Question: In one sentence, what is this figure communicating?
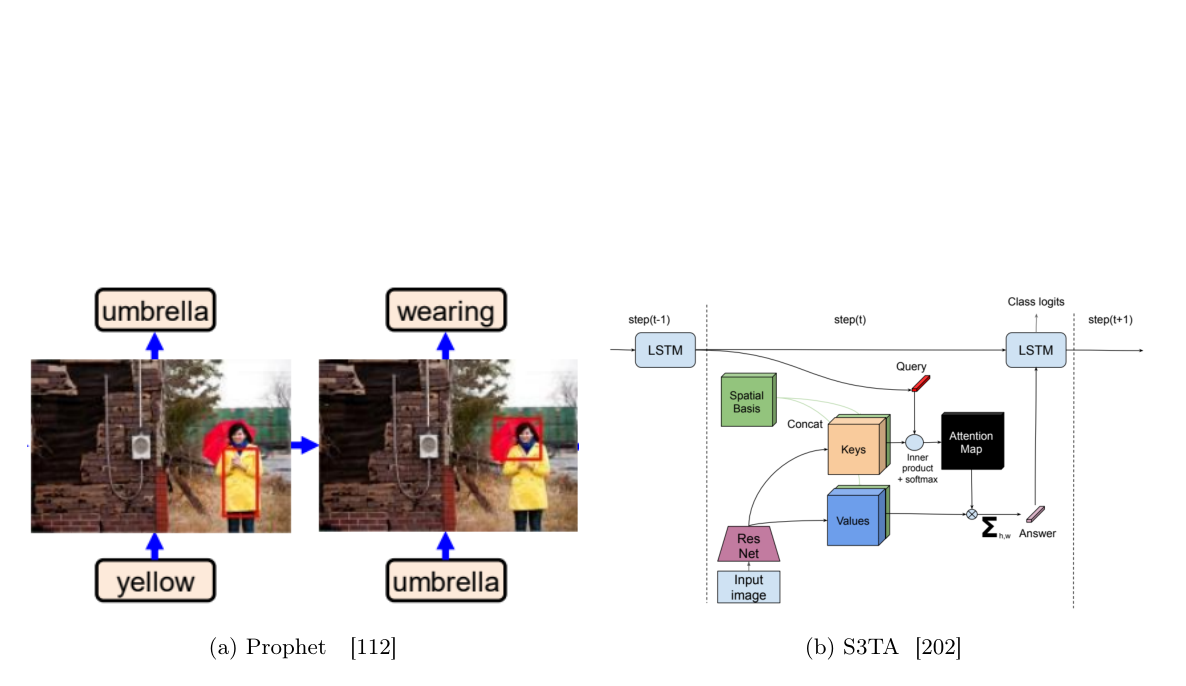
Answer: The core structure of logic-based attention methods such as Prophet attention [112] and S3TA [202] which are a type of attention that use logical networks such as RNN to infer the attention scores. Images are taken from the original papers and are best viewed in color.